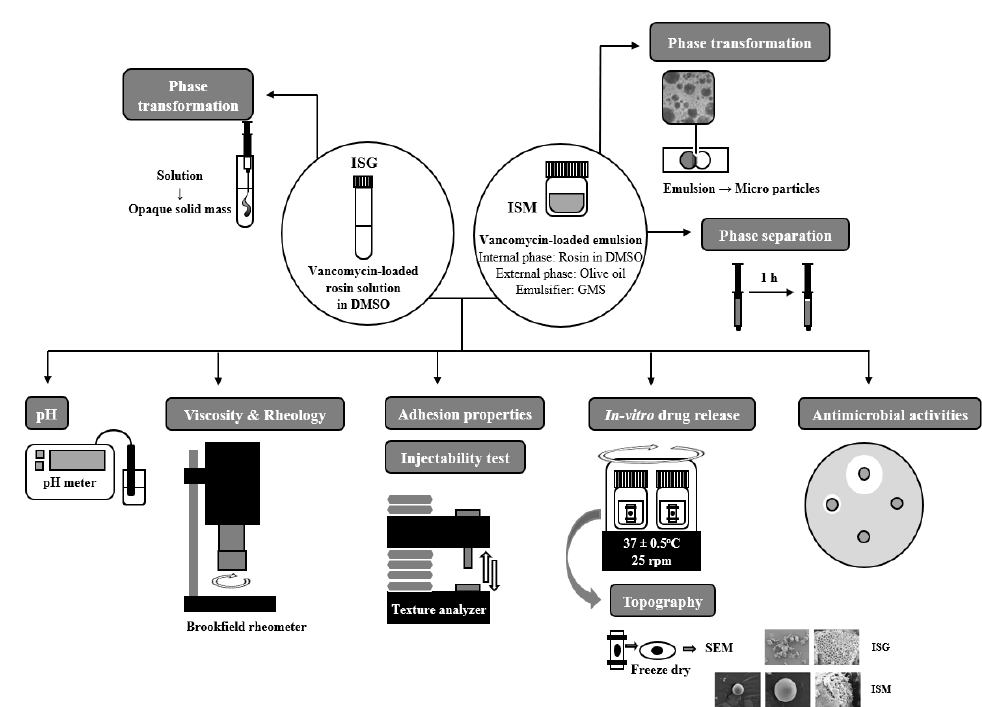
Figure 1. Schematic diagram of the experimental procedure.